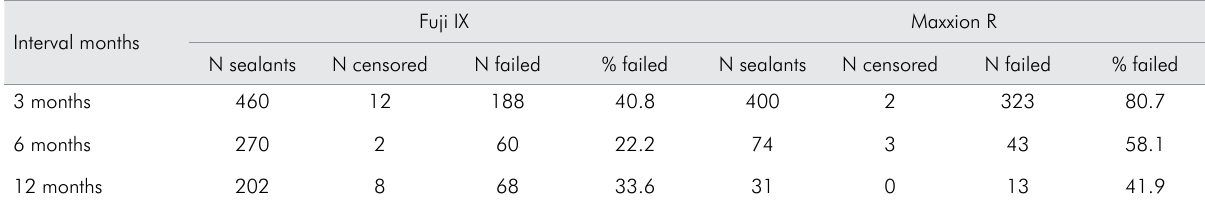
Table 1. Cumulative survival rates (%) of ART sealants placed in permanent molars, by GICs tested over a 12-month period.